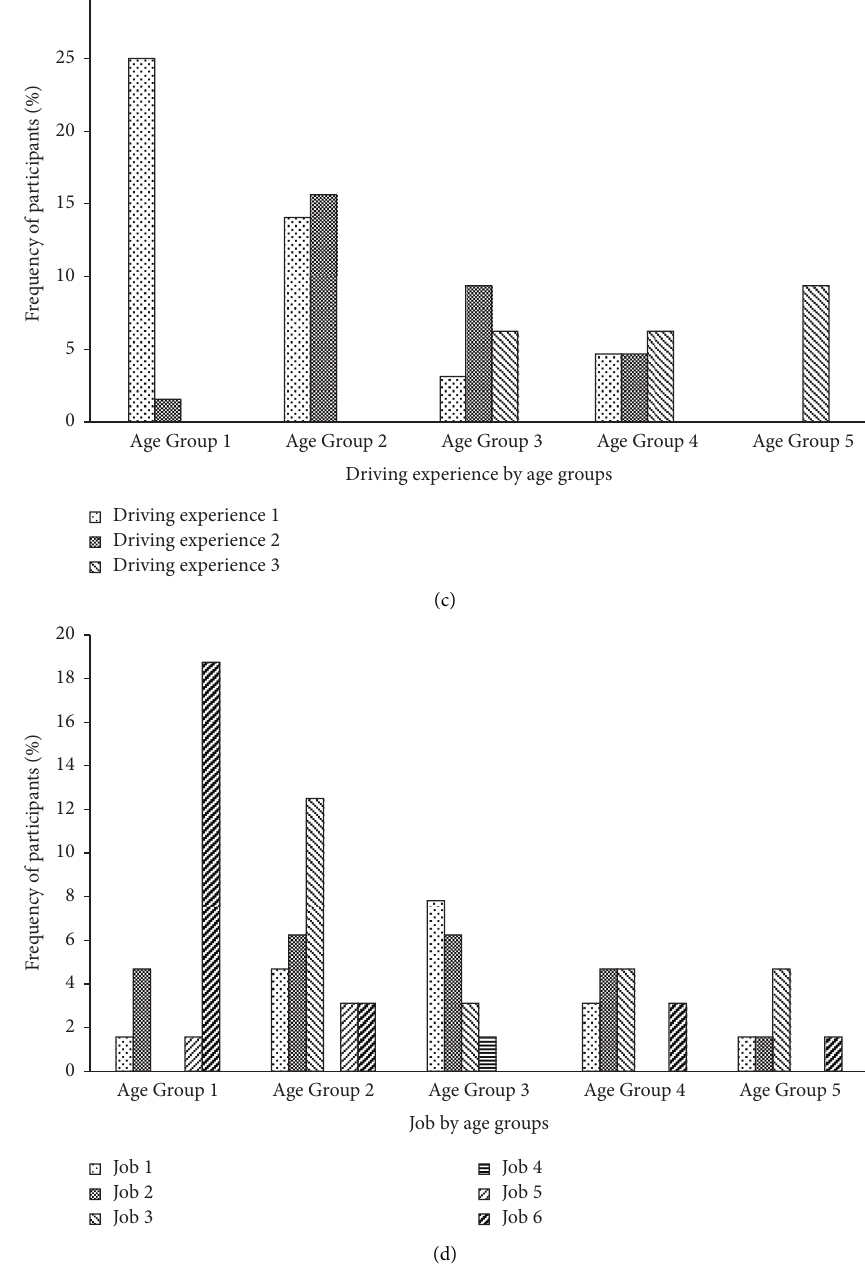
Figure 2: Detailed information of drivers’